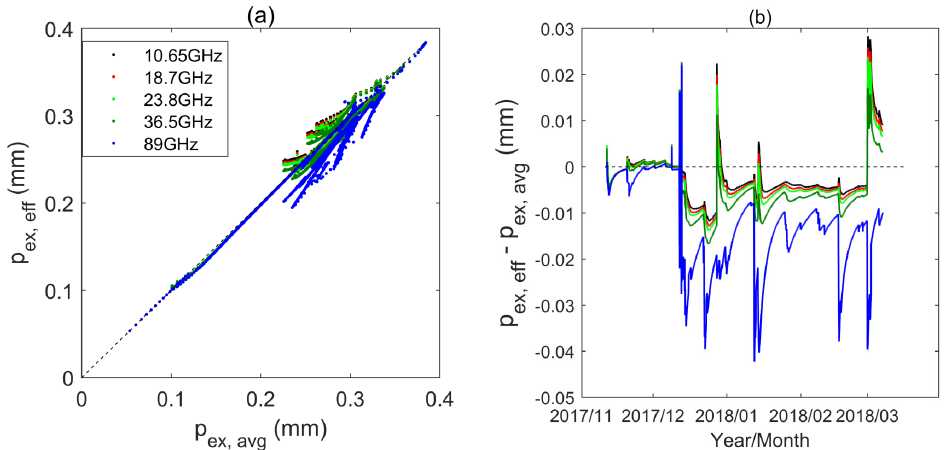
Figure 9. Comparison between effective exponential correlation length ( p ex,eff ) at different frequencies: ( a ) mass-weighted average exponential correlation length ( p ex,avg ) used in Options 1 and 4 versus p ex,eff used in Options 2 and 3; and ( b ) difference in p ex,eff at different frequencies using p ex,avg as the reference value. Table 3. Statistics for mean bias (MB), RMSE, and correlation coefficient (R) of simulated brightness temperature in dif- ferent bands and polarizations (Altay samples). The sample size was 3016. The values in bold represent the highest accu- racy among four methods.